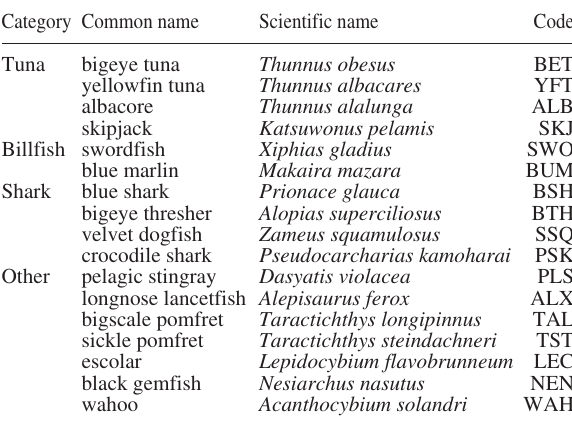
Table 1. – Species captured in the longline observer trip in the central-eastern Pacific Ocean in February-November 2006. Species listed here are only those analyzed in this